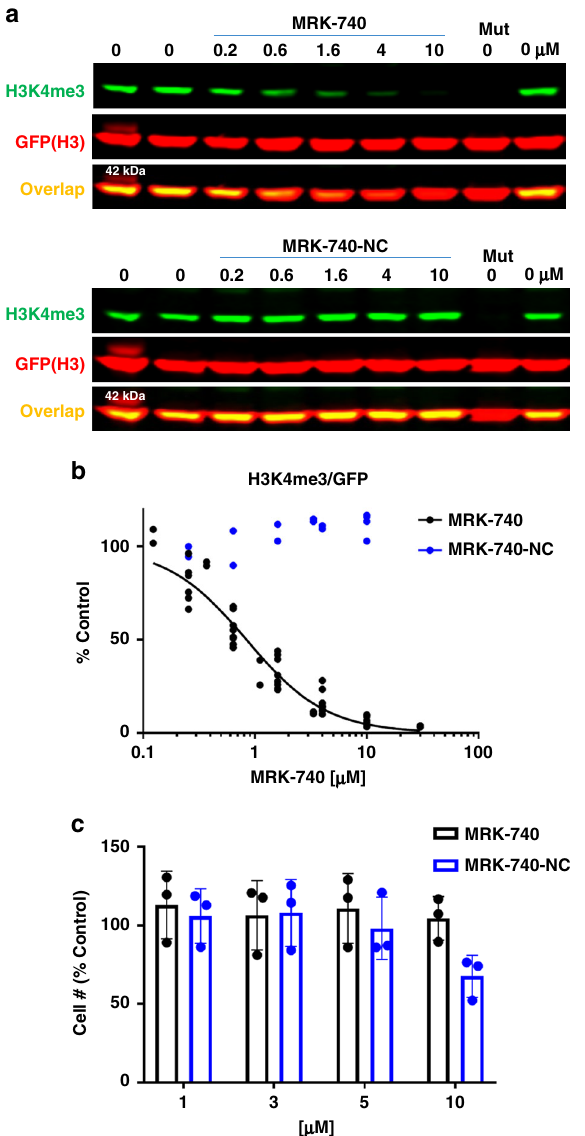
Fig. 6 MRK-740 inhibits PRDM9 activity in cells. a MRK-740 but not MRK740-NC decreases PRDM9-dependent K4 trimethylation of exogenous histone H3. HEK293T cells were co-transfected with H3-GFP and PRDM9-FLAG and treated with compounds at indicated concentrations for 20 h. Mut denotes PRDM9 catalytic mutant (Y357S). First and last lanes are controls at 0 µ M of compound. b The graph represents non-linear fi t of H3K4me3 fl uorescence intensities normalized to intensities of GFP (MRK-740 n = 10, 4 separate experiments, MRK-740-NC n = 4, 2 separate experiments). c MRK-740 and MRK-740-NC do not affect HEK293T cell growth up to 10 µ M. Cells were treated with compounds for 1 day. Cell number was measured using IncuCyte ™ ZOOM live cell imaging device. The results are mean ± sd, n = 3. Source data are provided as a Source Data fi